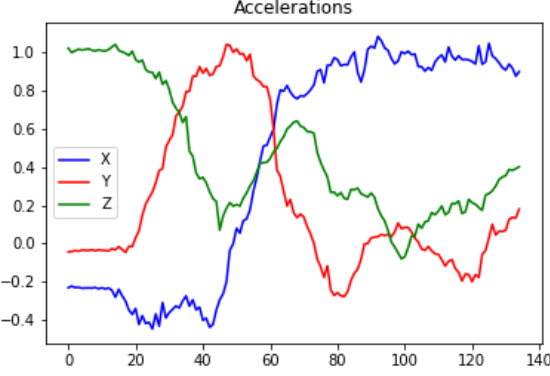
Figure 10. Accelerations of the users getting out of bed from right.